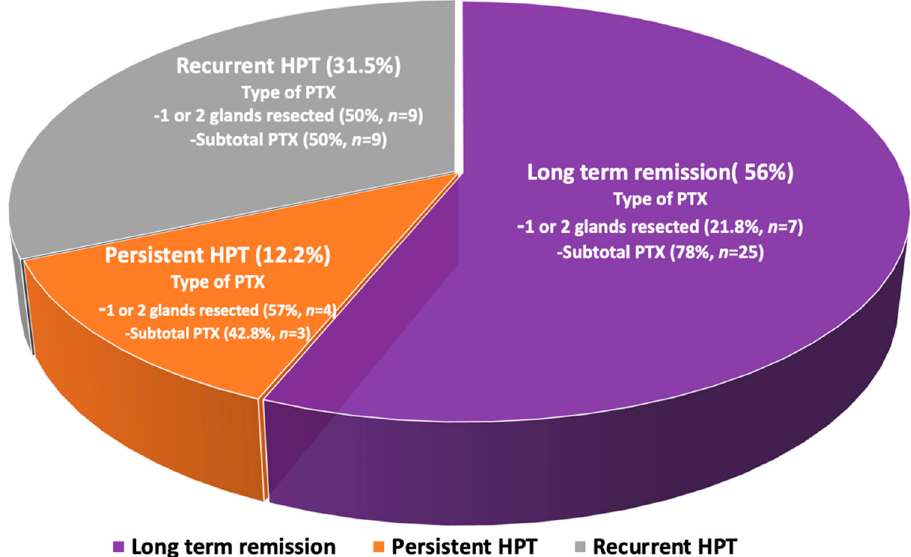
Figure 2. Schematic depiction of the outcome of the initial parathyroid surgery in MEN1-related PHPT.